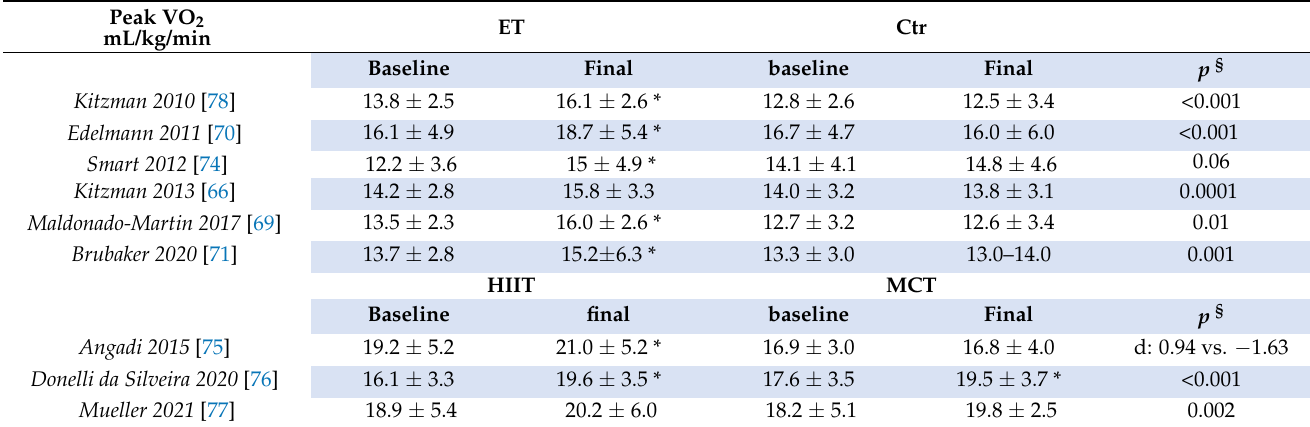
Table 1. Results of trials investigating the effects on peak VO 2 of exercise training in HFpEF.